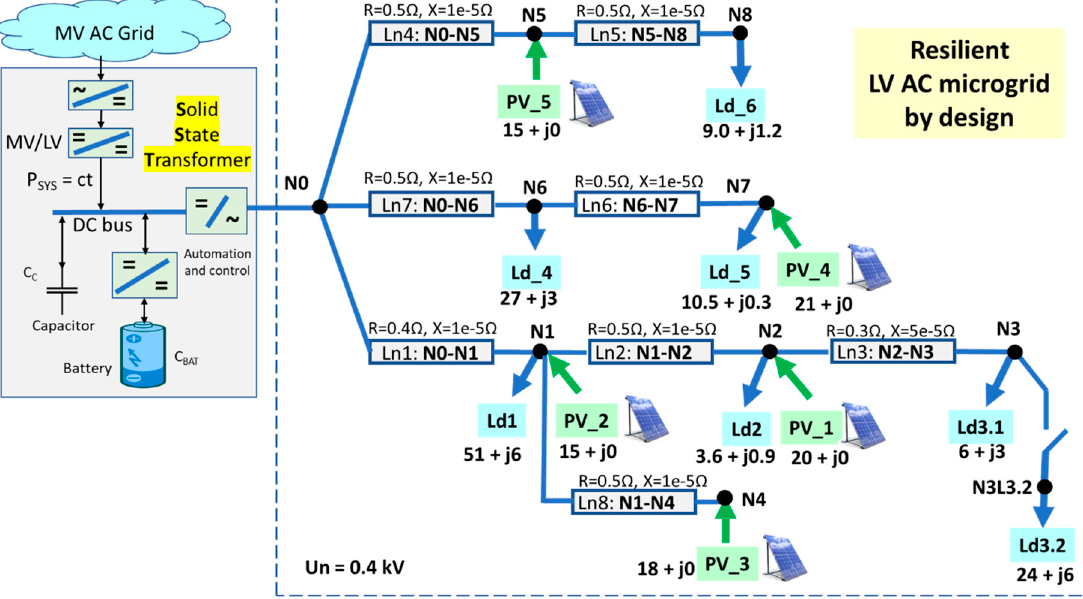
Figure 2. The tested low-voltage microgrid (the load demands and the PV injections are powers expressed in kW and kvar).